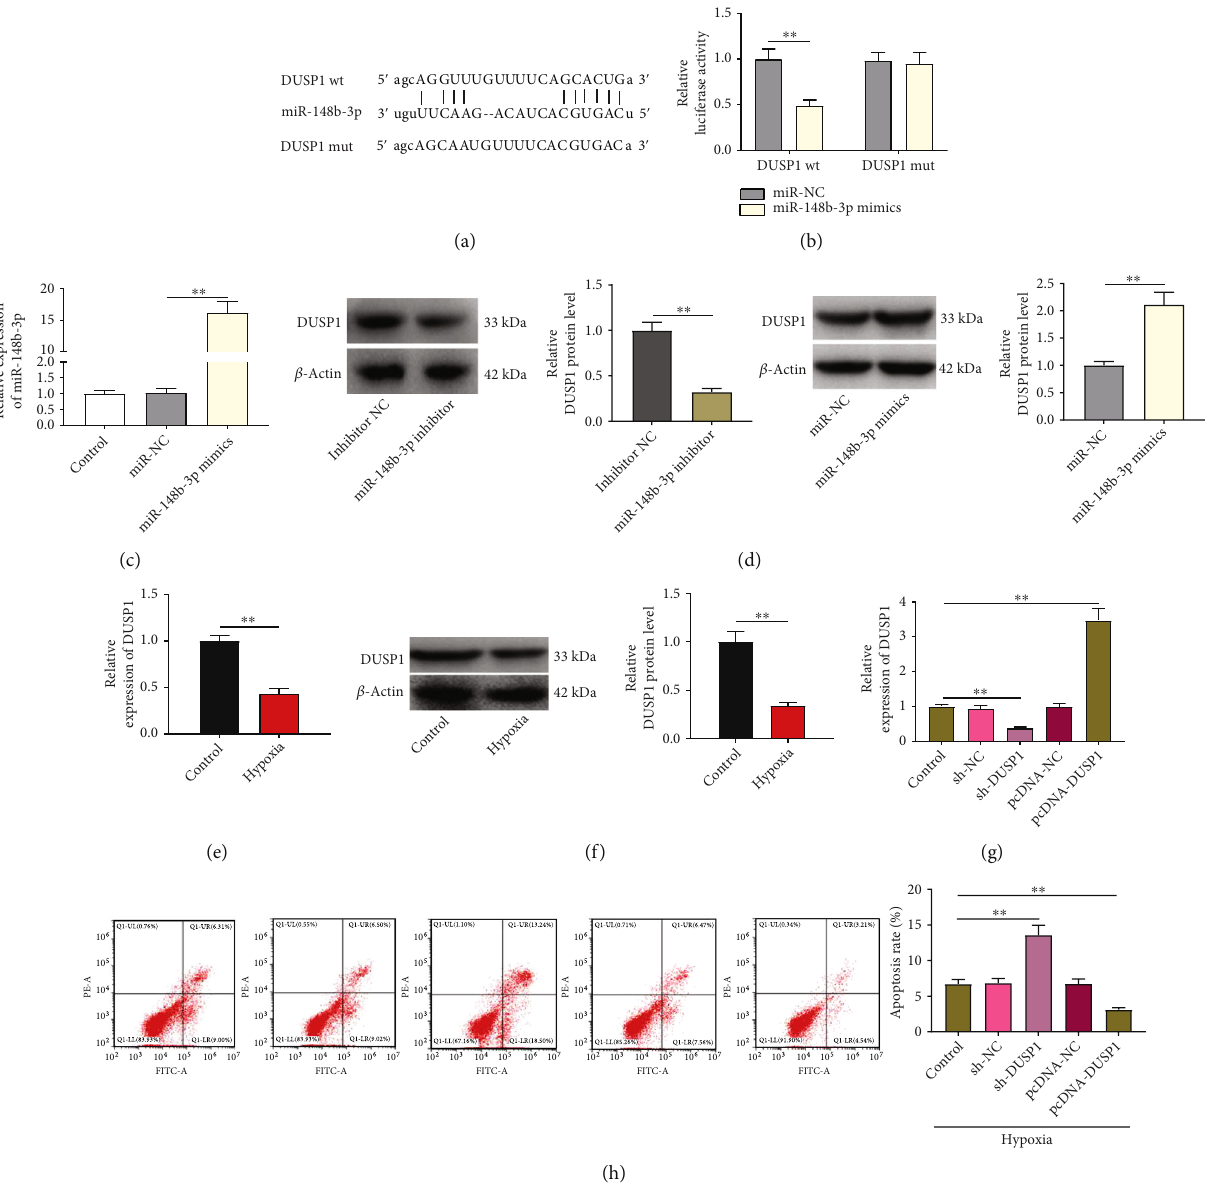
Figure 4: The target relationship between DUSP1 and miR-148b-3p. (a) A binding site of DUSP1 and miR-148b-3p was predicted by TargetScan and StarBase. (b) DLR assay of the target relationship between DUSP1 and miR-148b-3p. (c) The expression of miR-148b-3p in H9c2 cells transfected with miR-148b-3p mimics/miR-NC was detected by qRT-PCR. (d) The protein expression of DUSP1 in H9c2 cells transfected with miR-148b-3p inhibitor/inhibitor NC or miR-148b-3p mimics/miR-NC was detected by western blot. (e) The mRNA expression of DUSP1 in hypoxia-induced H9c2 cells was detected by qRT-PCR. (f) The protein expression of DUSP1 in hypoxia-induced H9c2 cells was detected by western blot. (g) The mRNA expression of DUSP1 in hypoxia-induced H9c2 cells transfected with sh-DUSP1/sh-NC/pcDNA-NC/pcDNA-DUSP1 was detected by qRT-PCR. (h) Cell apoptosis was detected by fl ow cytometry. ∗∗ P < 0 : 01